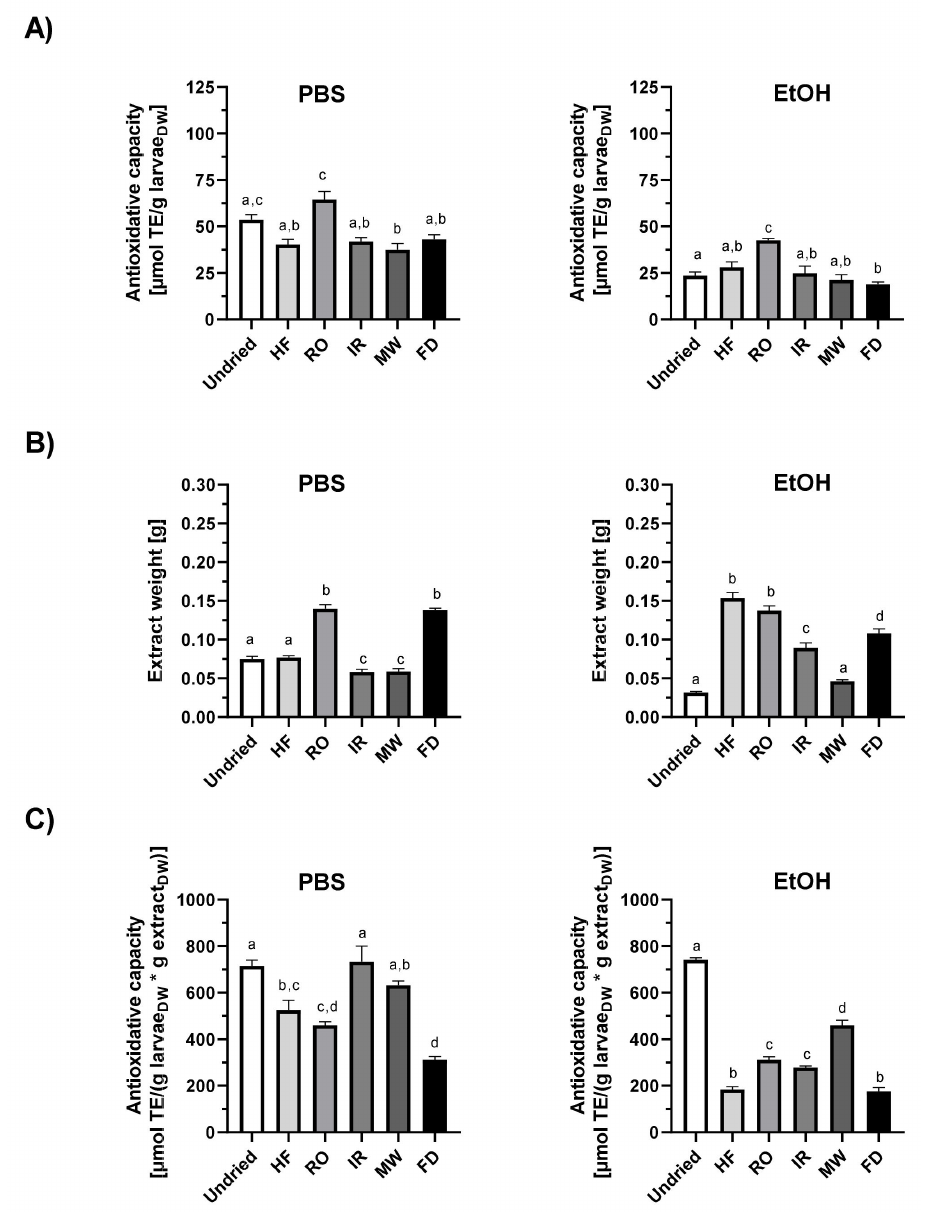
Figure 2. TEAC antioxidant capacity of T. molitor larvae extracts. Antioxidant capacity of PBS or ethanol mealworm extracts measured by ABTS • + reduction and normalized to ( A ) the larval dry weight or ( C ) the larval dry weight per extract dry weight. ( B ) Dry weight of extracts obtained from 0.5 g larval material each as a measure of extraction efficiency. Data are shown as means ± SEM of three replicates. Significantly different means within one panel do not share the same letters (analysed by one-way ANOVA with Tukey’s multiple comparison test, p < 0.05). DW = dry weight, TE = Trolox equivalents. HF = high-frequency dried, RO = rack oven-dried, IR = infrared dried, MW= microwave dried, FD =